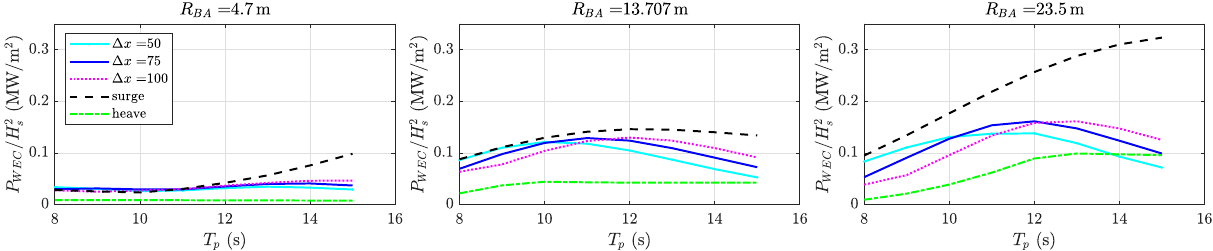
Figure 7. Power as a function of peak period for D BA / R BA = 1.00 and varied separation distance or pure surge/heave coupling. Left to right: varied BA